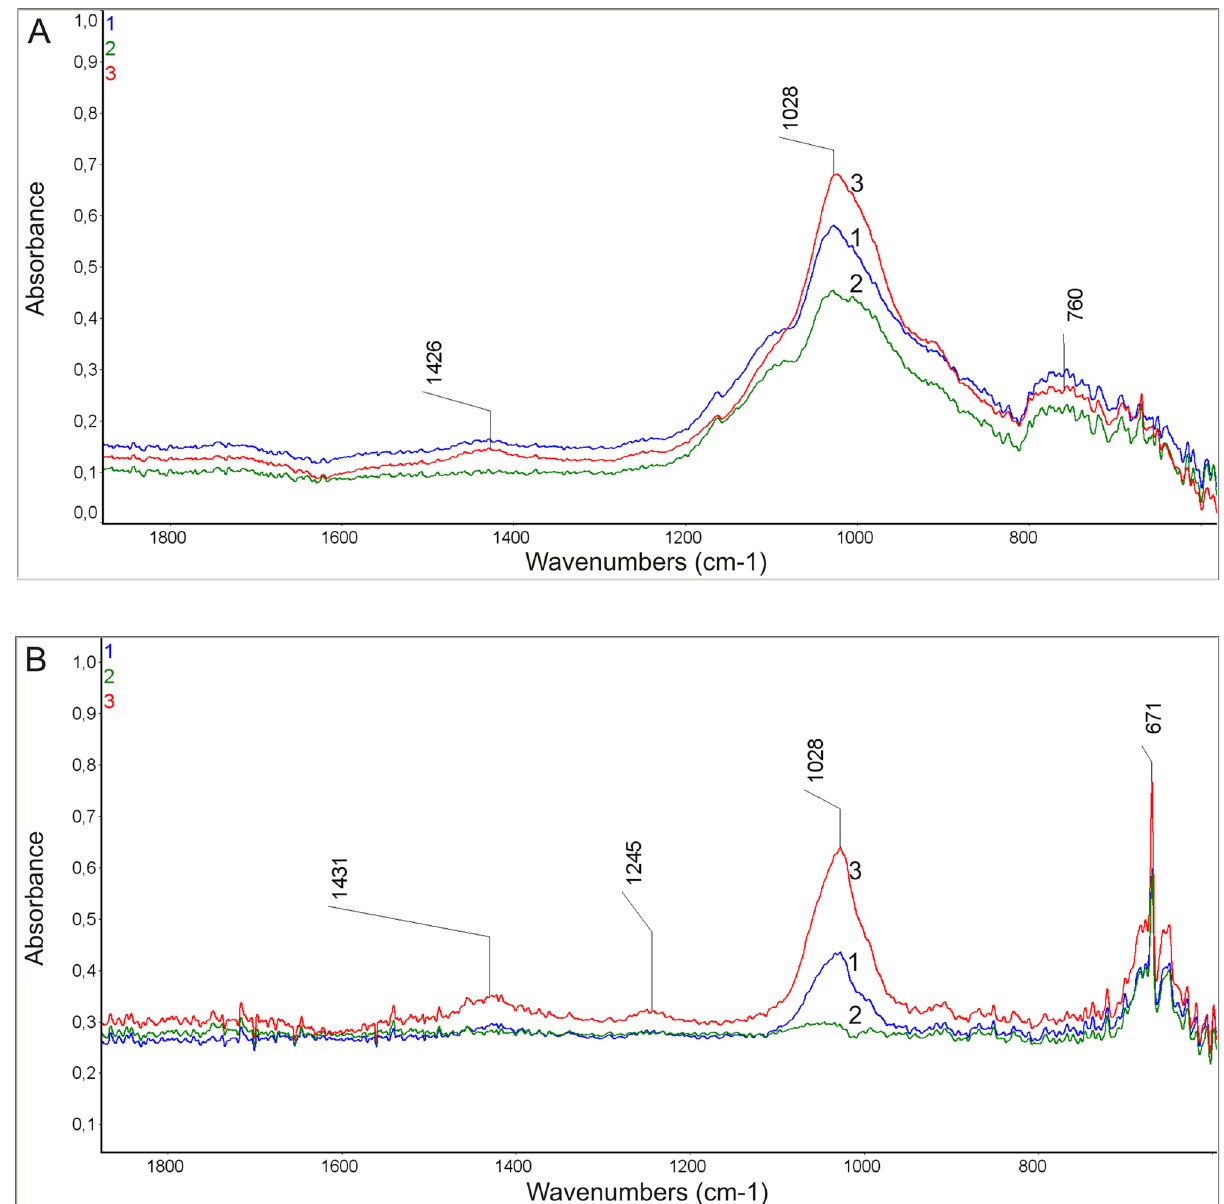
Figure 11. FTIR spectra made with the ATR technique from the solution: (A) algal suspension (pellet), (B) supernatant fraction (after removal of the fixative solution); sample 1—Longyearbreen Glacier, height 417 m; sample 2—Upper Foxfonna Glacier, height 789 m; sample 3—Lower Foxfonna Glacier, elevation 609